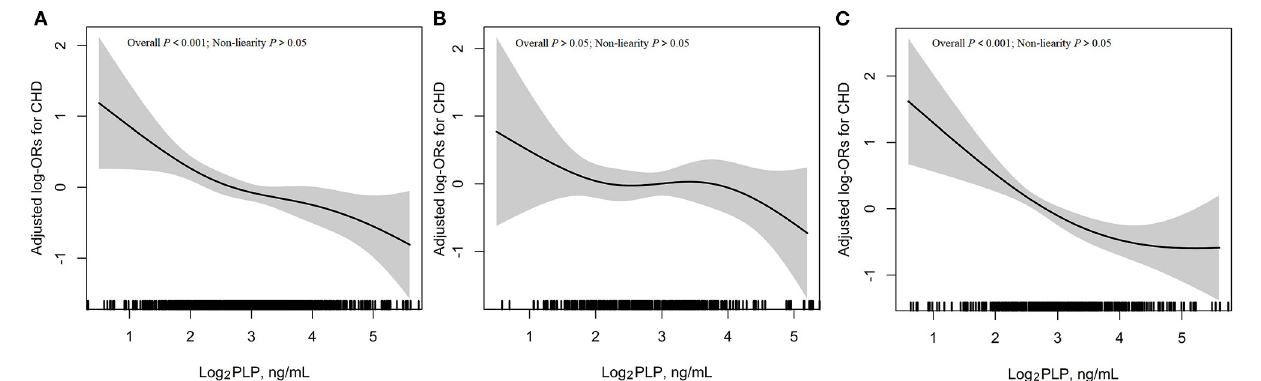
FIGURE 3 | Association between plasma log 2 PLP and risk of CHD. (A) Overall population; (B) Men; (C) Women. Adjustment factors included sex (only for overall population), age, BMI, smoking status, drinking status, hypertension, diabetes, hyperlipidemia, family history of CHD and hcy.